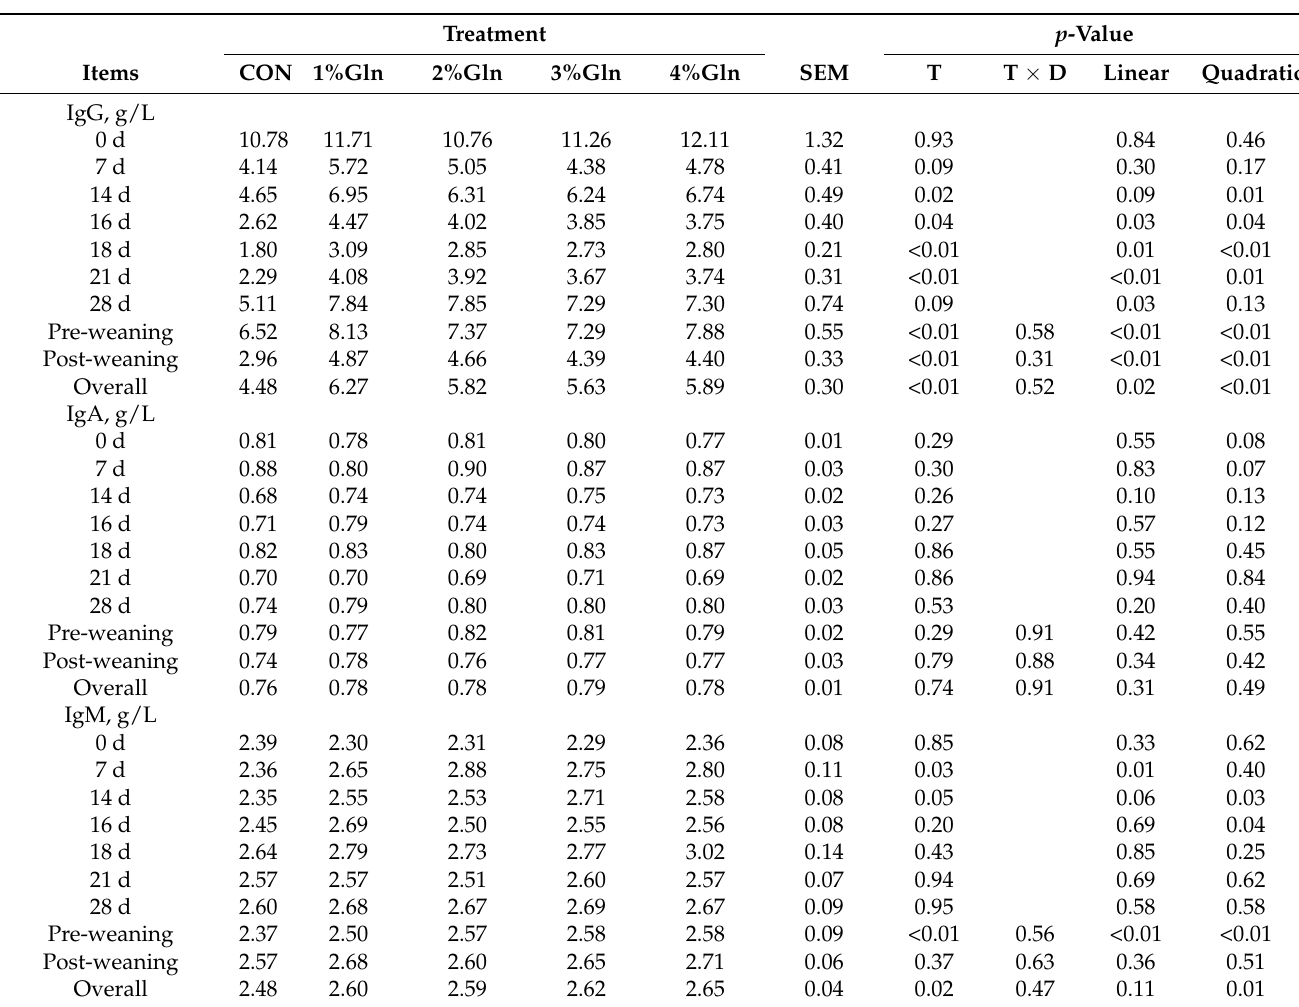
Table 5. Serum immune indicators of calves among different groups (N = 9 per group).